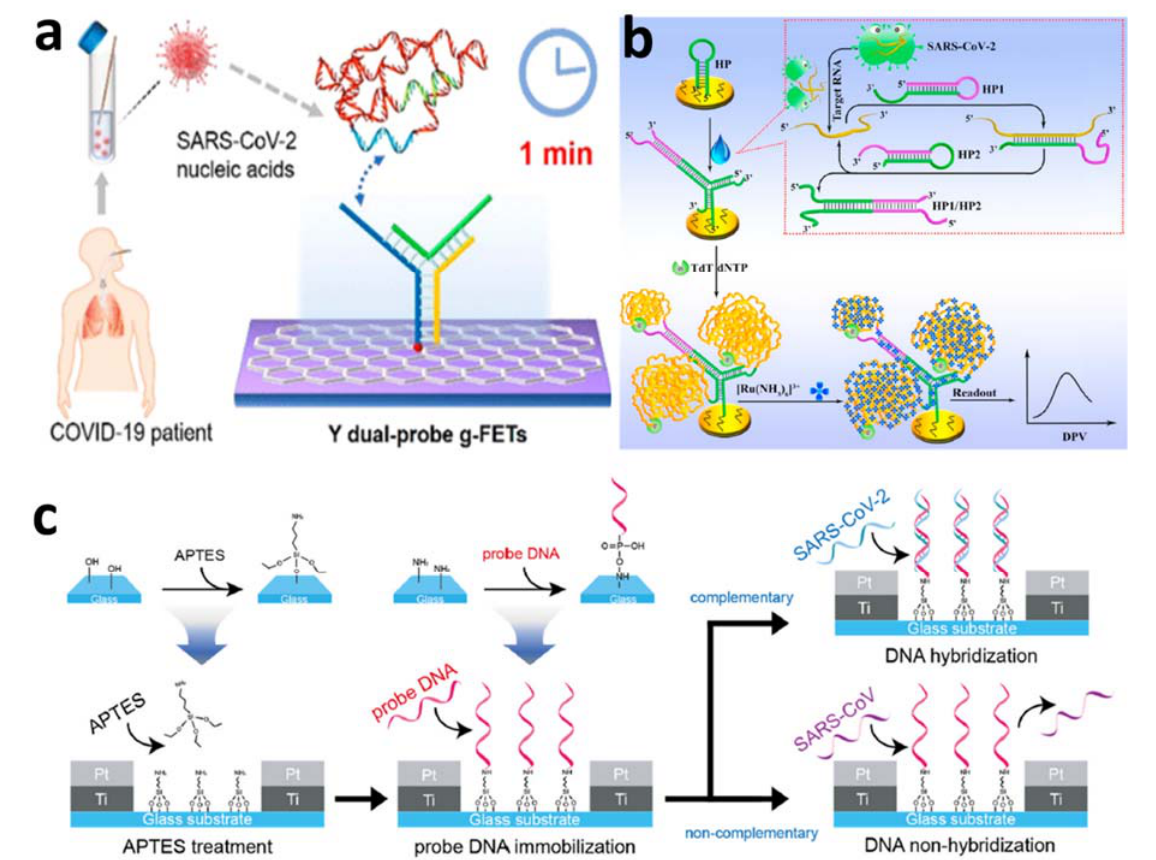
Figure 8. ( a ) Schematic of the Y-dual probe/graphene-based FET biosensor for SARS-CoV-2 NA detection (adapted from ref. [105]). Copyright 2021 American Chemical Society. ( b ) Schematic of the operation principle of SARS-CoV-2 NA monitoring by combining the signal amplification strategy (reproduced from ref. [106]). Copyright 2021 Elsevier. ( c ) Schematic of the fabrication of interdigitated platinum/titanium electrodes treated with APTES followed by probe DNA immobilization and the hybridization of target complementary DNA for SARS-CoV-2 NA detection (reproduced from ref. [107]). Copyright 2021 Elsevier.